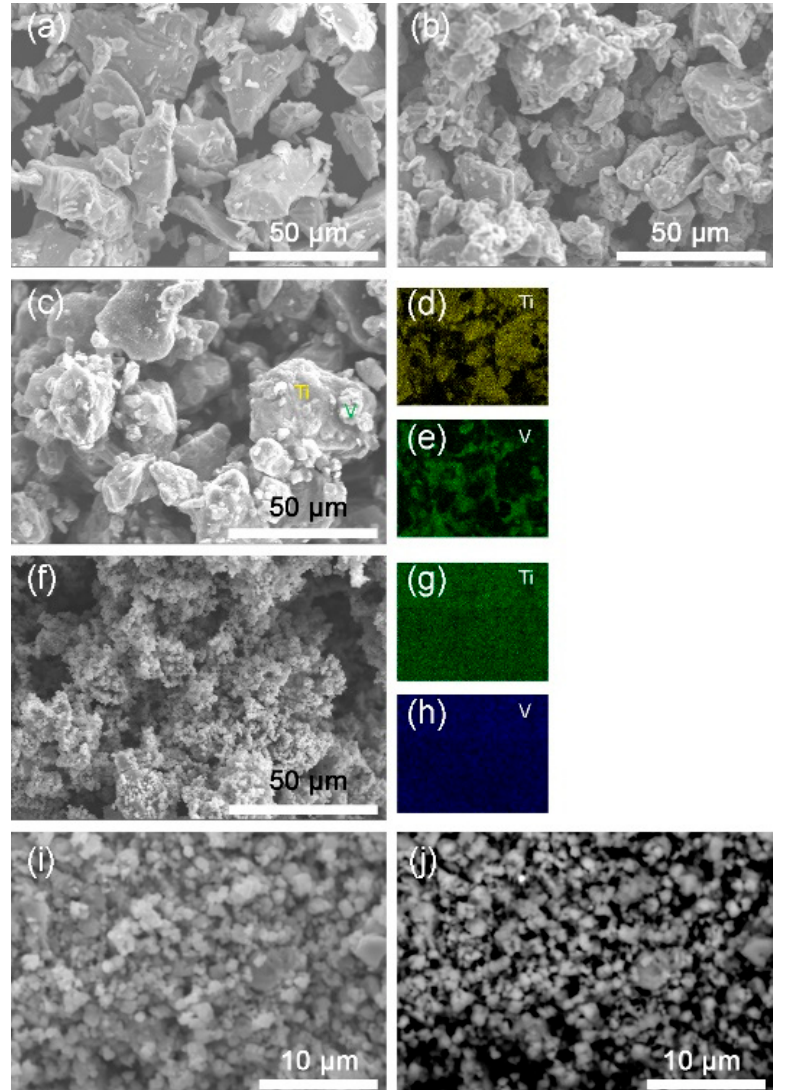
Figure 2. Secondary electron-scanning electron microscope (SE-SEM) images of ( a ) Ti; ( b ) V; ( c ) the mixture of Ti and V; ( f ) and ( i ) 10 h-milled Ti 50 V 50 -10% C alloy. ( d )–( e ) and ( g )–( h ) are energy dispersive X-ray spectrometer (EDS) mappings of Ti, V elements for images ( c ) and ( f ), respectively. ( j ) Backscattered electron-scanning electron microscope (BSE-SEM) image of the milled Ti 50 V 50 -10% C alloy.